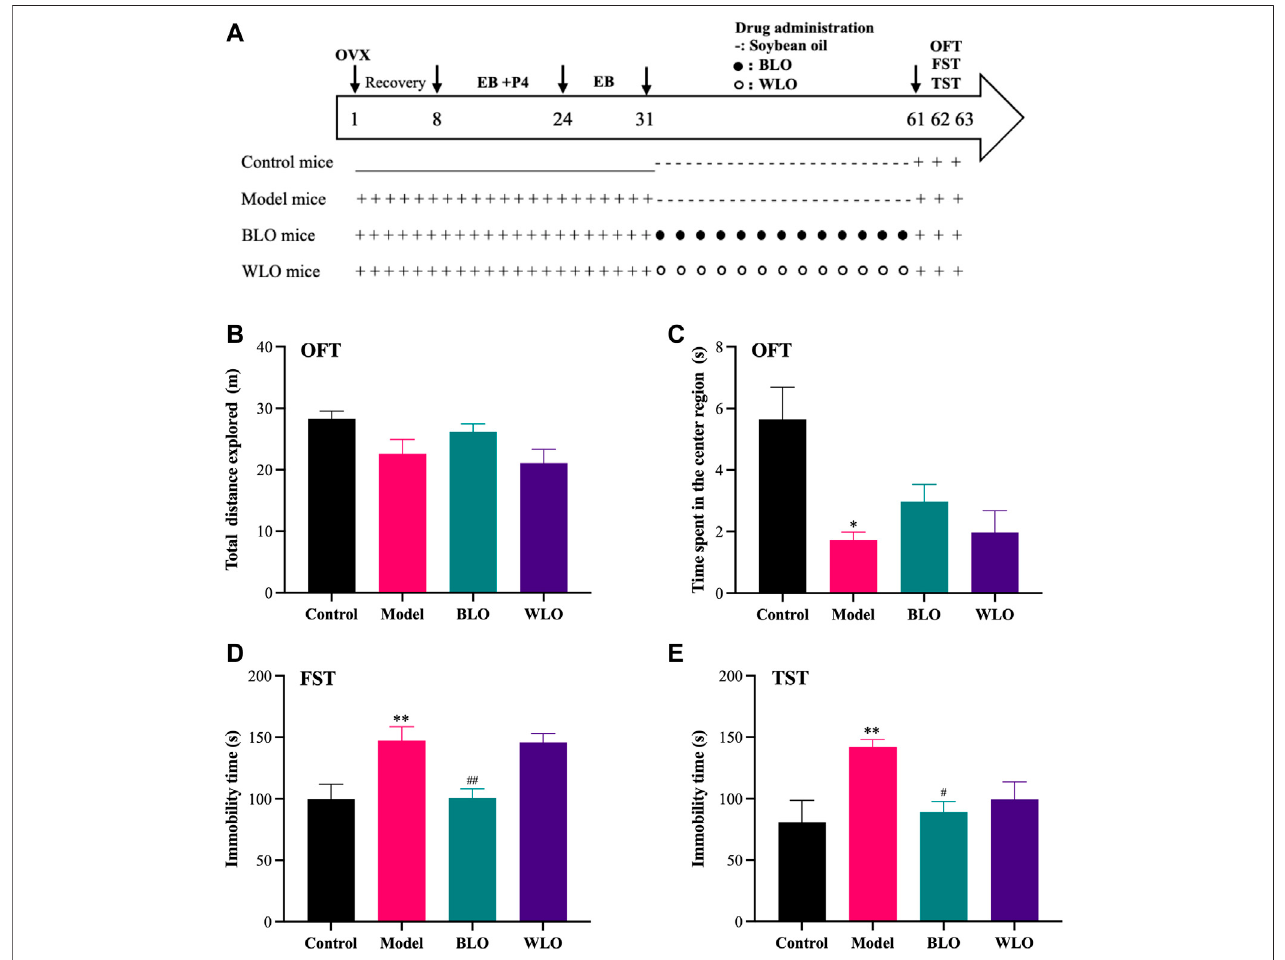
FIGURE2| TheeffectsofBLOandWLOonthedepression-relatedbehaviorsinPPDmodelmice(X±SEM, n =8). (A) :Timecourseoftheexperimentalprocedure. (B,C) :ThetotaldistancesexploredandthetimespentinthecenterregioninOFT. (D,E) :TheimmobilitytimeinFSTandTST.* p < 0.05vs.Controlgroup; # p < 0.05, ## p < 0.01 vs. Model